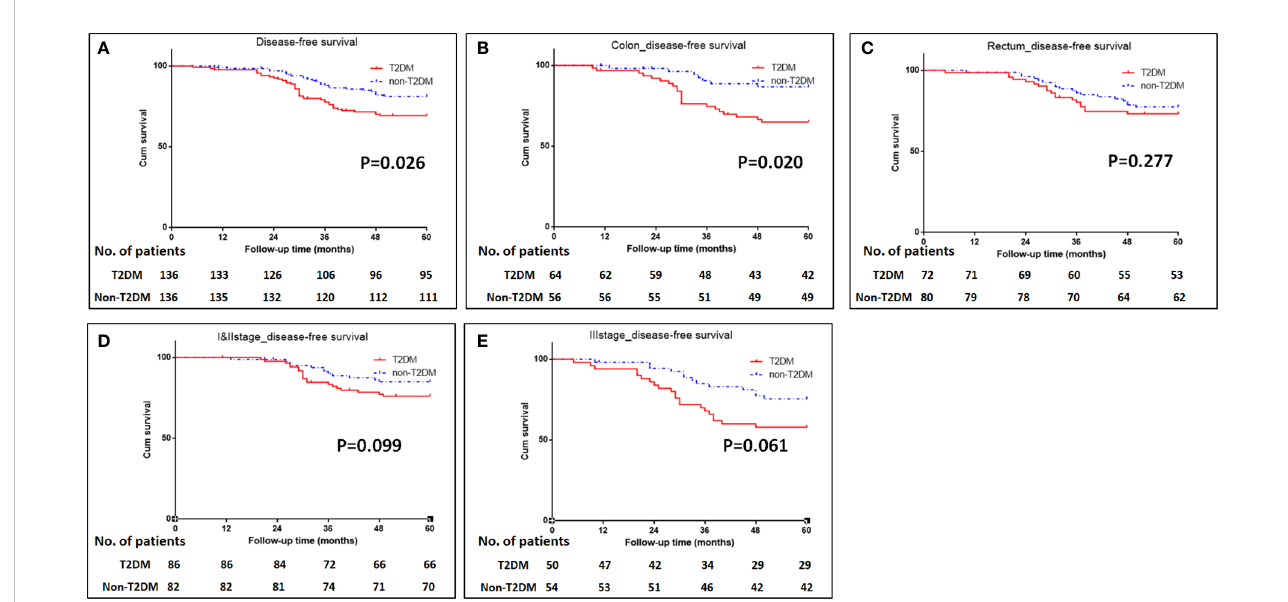
FIGURE 2 Kaplan-Meier analysis of disease-free survival in patients with T2DM. (A) Kaplan-Meier analysis of disease-free survival for all patients. (B-C) Kaplan-Meier analysis of disease-free survival for patients with colonic cancer (B) or rectal cancer (C) . (D, E) Kaplan-Meier analysis of disease-free survival for CRC patients with TNM I&II stage (D) or III stage (E)